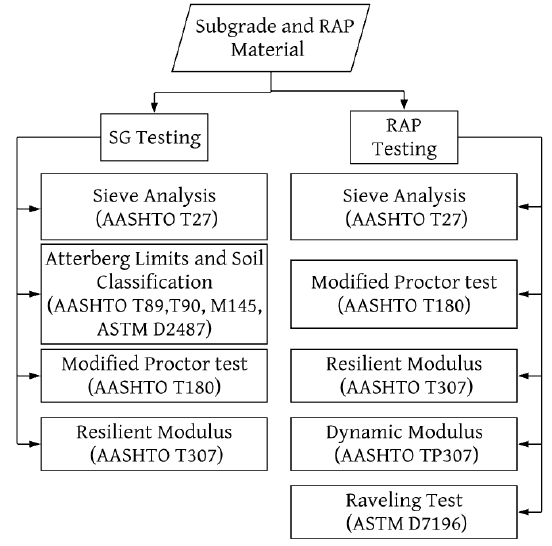
Figure 3. Summary of laboratory testing for SG and RAP.